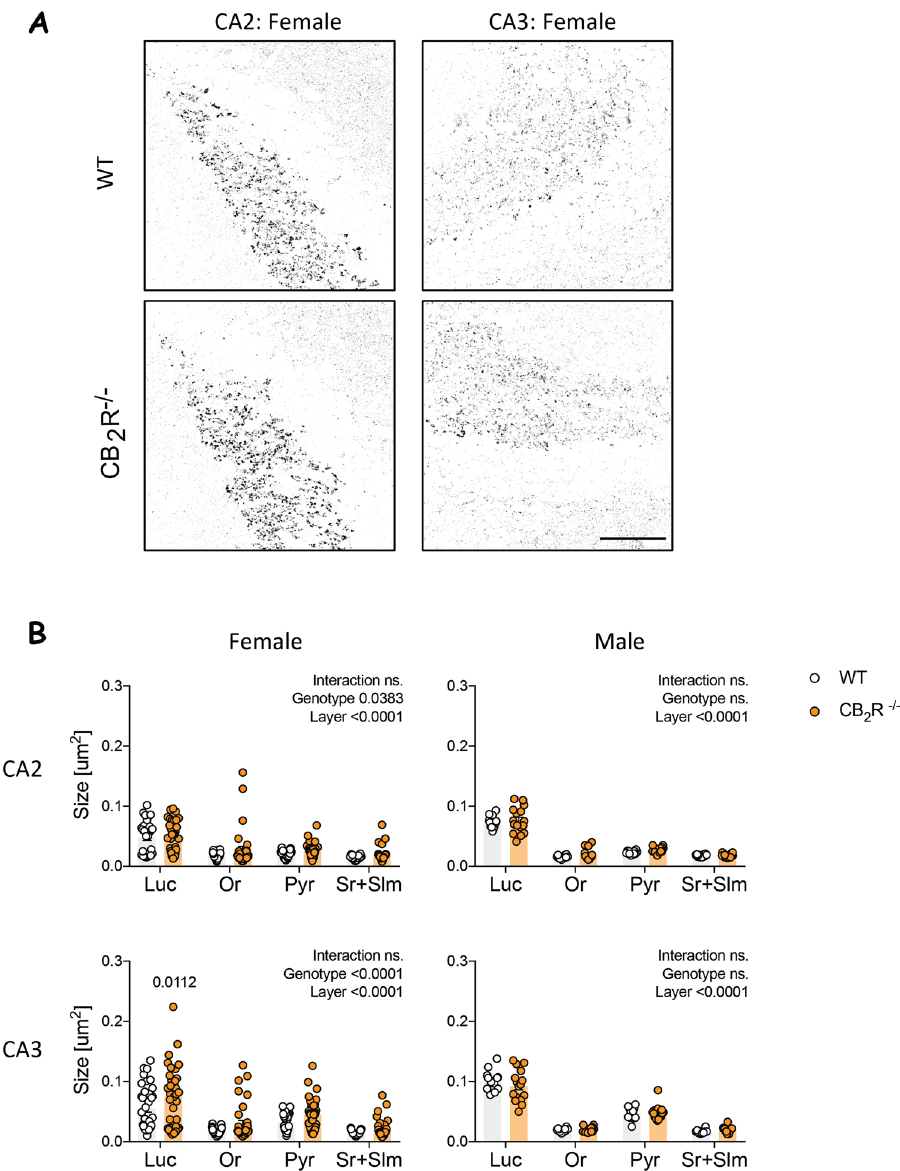
Figure 2. Average size of synapsin-I particles is increased after CB 2 R deletion in females. ( A ) Example images show binary image of synapsin-I. Scale bar: 50 µm. ( B ) Quantification of synapsin-I mean puncta size (detected puncta > 0.005 µm). Or stratum oriens, Luc stratum lucidum, Pyr stratum pyramidale, Sr + Slm stratum radiatum and stratum lacunosum-moleculare. White circle—WT; orange circle—CB 2 R −/− mice. Each datapoint represents one image. Left panel—female mice (WT: n = 28–35 images from N = 9 mice; CB 2 R −/− : n = 31–36 images from N = 9 mice); right panel—male mice (WT: n = 12 images from N = 3 mice; CB 2 R −/− : n = 16 images from N = 4 mice). Top panel—CA2 region; bottom panel—CA3 region. Data is displayed as mean value ± SEM. Data was analyzed by two-way ANOVA followed by Sidak’s multiple comparison test. The exact p-values are indicated on the graph and reported in Supplementary Table